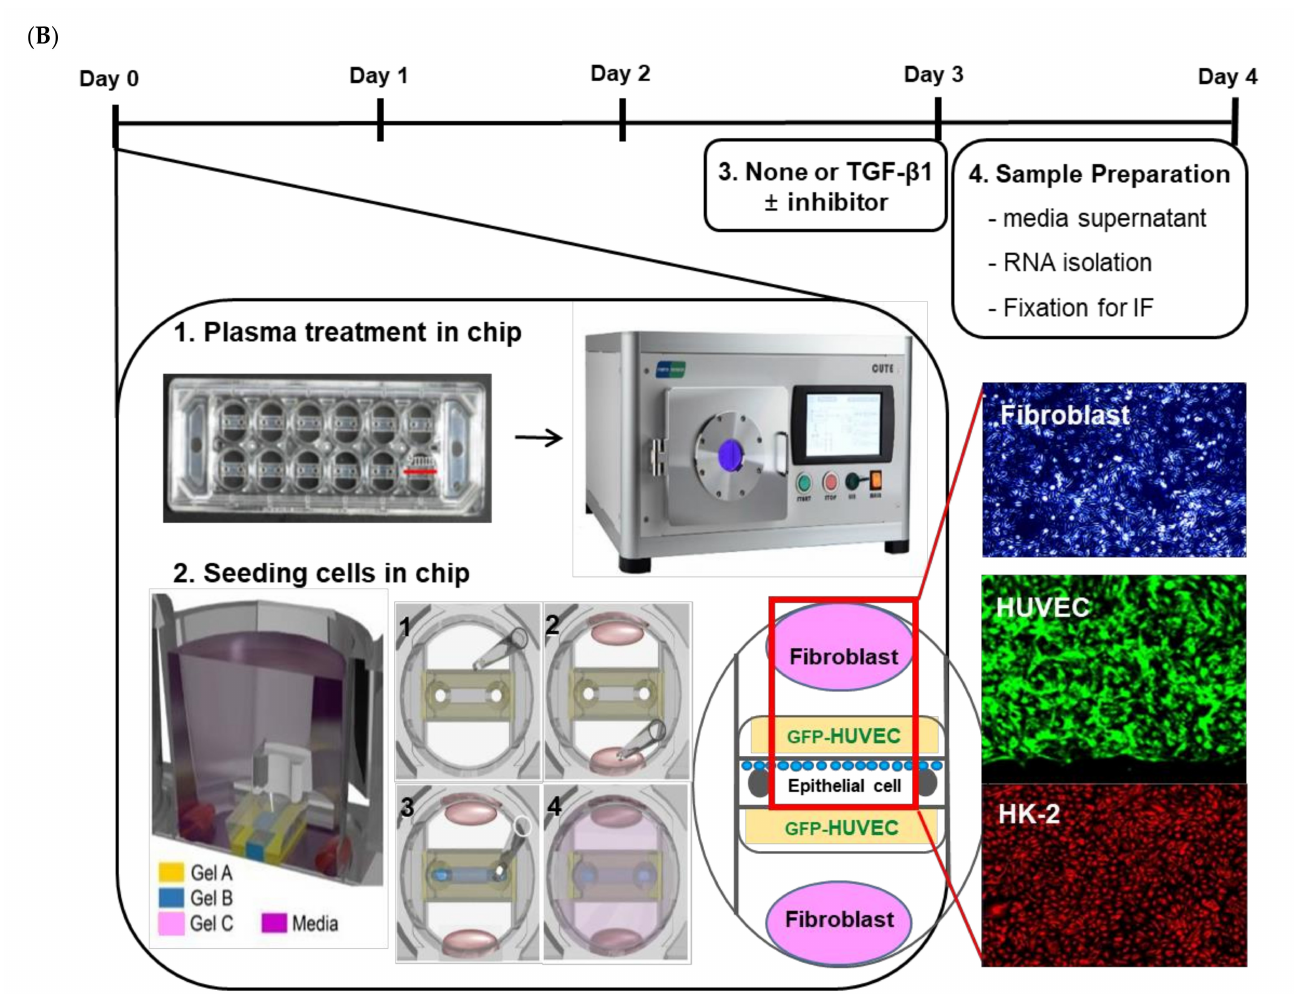
Figure 3. Sample image with device schematic demonstration of the fabrication and experimental schedule. ( A ) The top two images show the layout. The left image shows an overall top-down photo of the device. The bottom images show the cross-section. Schematic view detailing the dimensions of the liquid guides. ( B ) This figure describes the experimental schedules for fibrosis-mimicking devices. Four-step loading process for each well. Location of each hydrogel patterning area, as well as the placement of the media in top-down and isometric cross-section. (1) A total of 1.5 µ L of hydrogel 1 is spontaneously guided into the central channel. (2) Central channel is filled with 5 µ L of hydrogel. (3) A total of 10 µ L of hydrogel 3 are patterned on the reservoir floor. (4) A total of 200 µ L of media are dispensed. Red scale bar = 9